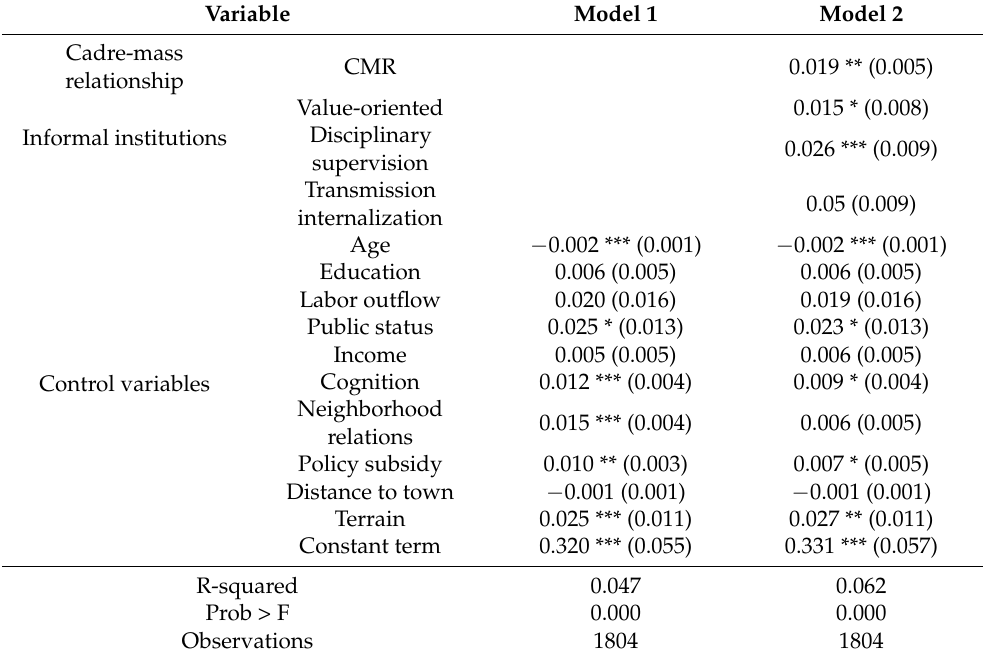
Table 4. The influence of informal institution informal institutions and CMR on farmers’ participation in